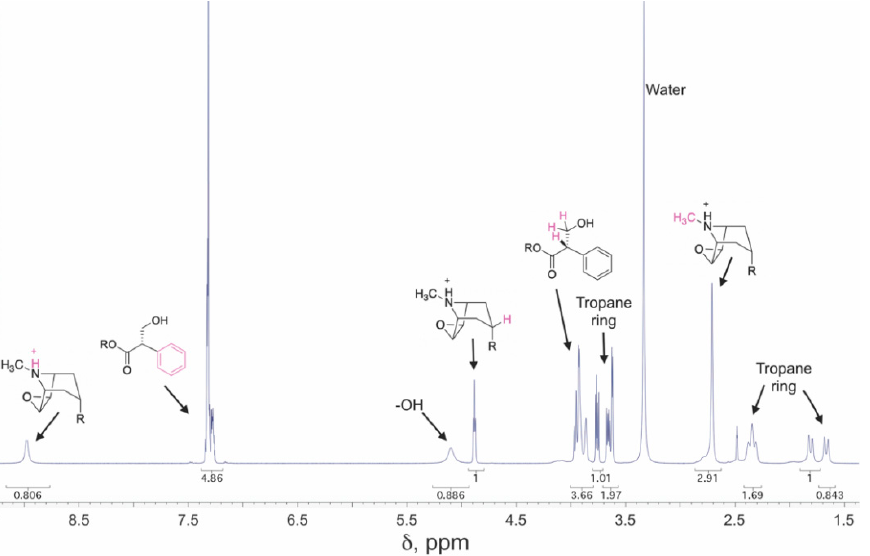
Figure 4. 1 H-NMR spectrum (500 MHz, in DMSO- d 6 ) of scopolamine ( 2 ). Indicated peaks correspond to the structural features highlighted in magenta.